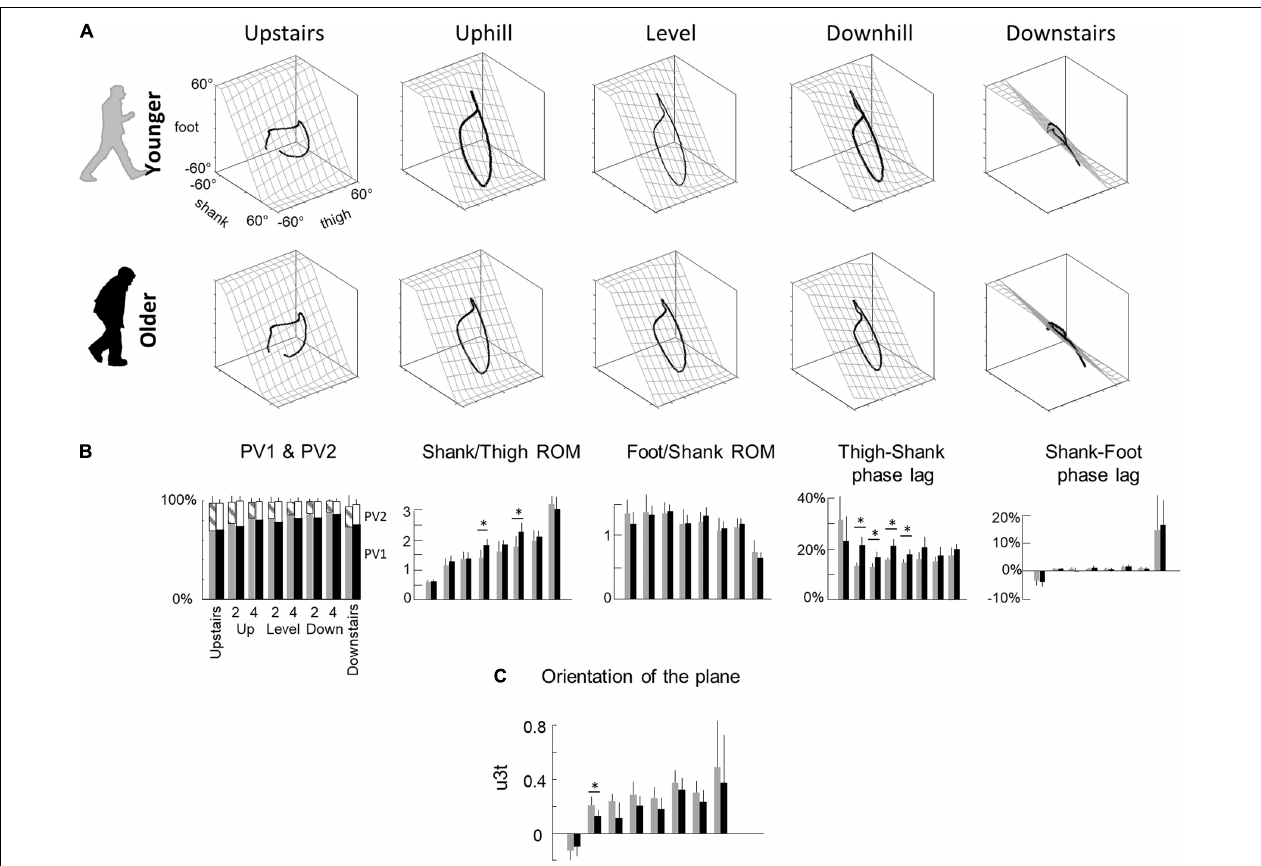
FIGURE 3 | Planar covariation of elevation angles. (A) Covariation of the ensemble-average limb-segment elevation angles across young (up) and elderly adults (bottom) in all conditions. Note that when the elevation angles of thigh, shank, and foot are plotted one vs. the other in a x-y-z space, they co-vary along a loop constrained on a plane (x–y). Grids show the best-fitting plane. (B) Average percentage of variance accounted for by the first (PV 1 ) and second (middle – PV 2 ) eigenvector of the principal component analysis, average amplitude ratios between the range of motion of adjacent segments and phase lags between time curves of elevation angles of adjacent segments. Bars are presented for each condition and at each speed (2 and 4 indicate the speed in km h − 1 ). (C) The direction cosines of the normal to the covariation plane with the positive semi-axis of the thigh angular coordinates (u3t). Other indications as in Figure 2